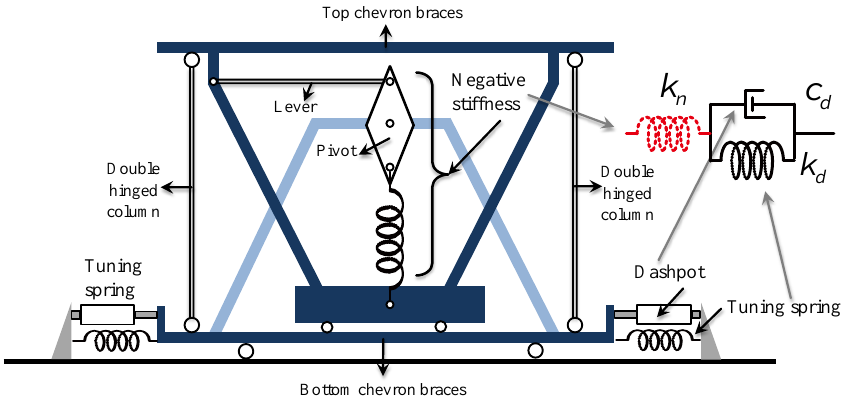
Figure 1. Physical realization and mechanical model of a negative-stiffness amplification system (NSAS) .